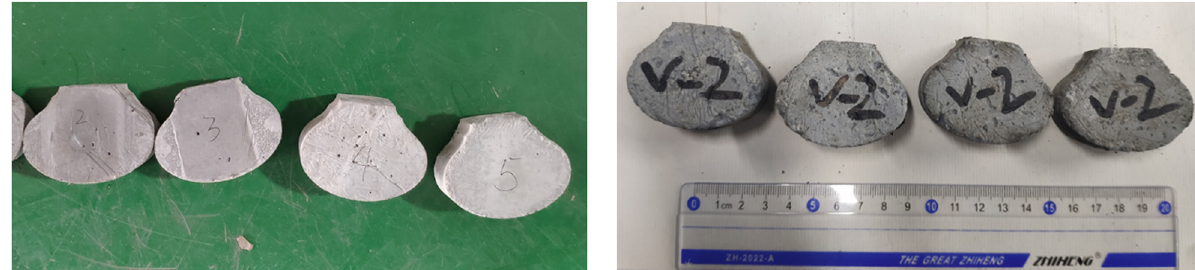
Figure 1: Specimens for single fi ber pullout